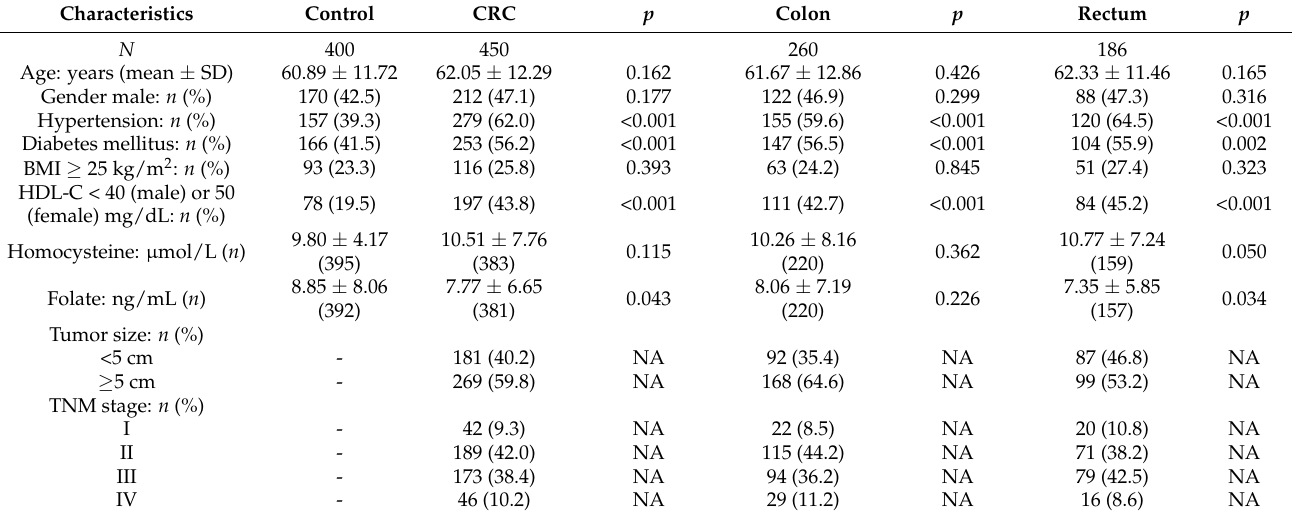
Table 1. Baseline characteristics of colorectal cancer patients and control